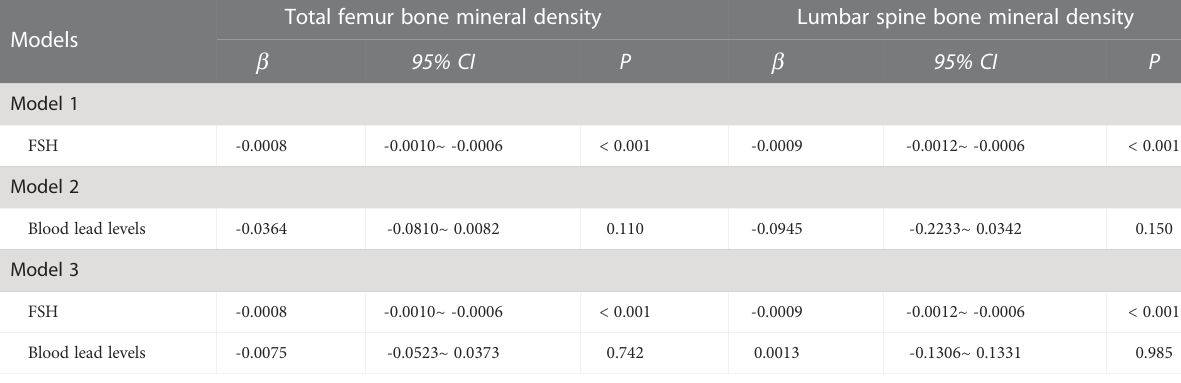
TABLE 2 The associations of FSH and blood lead levels with bone mineral density ※ .